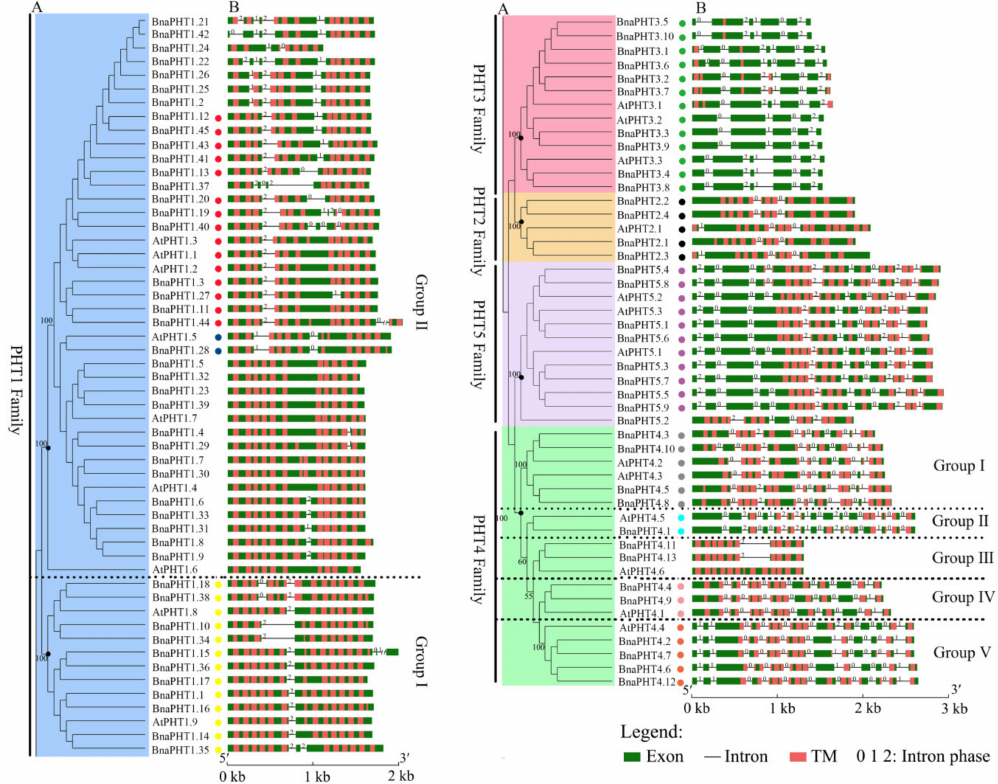
Figure 2. Gene structures of candidate PHT genes ( PHTs ) across di ff erent families. ( A ) Phylogenetic analysis of PHT families in B. napus and Arabidopsis . Colored background indicates genes belong to di ff erent families. The dashed lines represent the genes belong to di ff erent groups. ( B ) Gene structure of PHTs in B. napus ( BnaPHTs ) and Arabidopsis ( AtPHTs ). Exon was indicated by green boxes, transmembrane (TM) by red boxes, and the spaces between the colored boxes correspond to introns. Numbers 0, 1, 2 represent introns in phases 0, 1, and 2, respectively. The colored dots represent the conservative intron insertion patterns corresponding to the Figure S2,